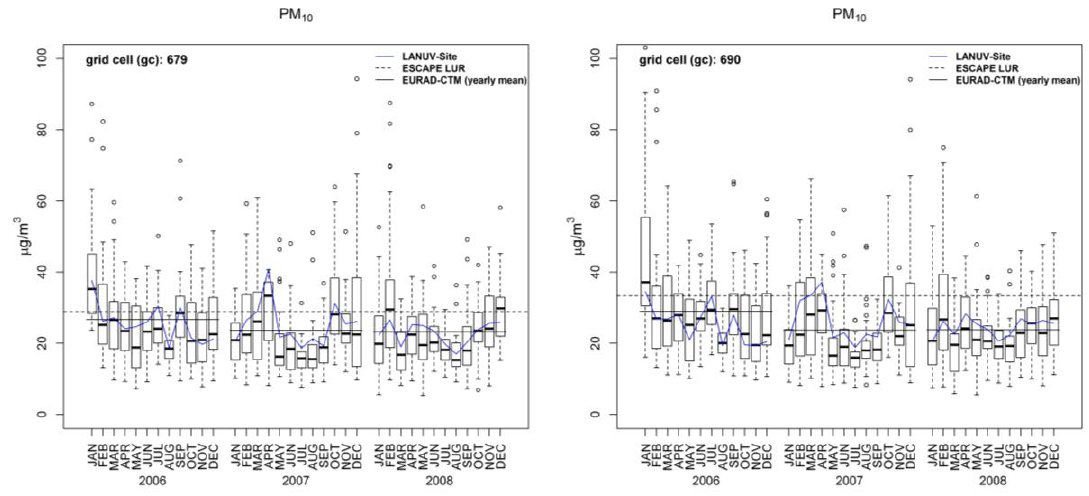
Figure 3. Box plots of air pollution concentrations of PM 10 over time for two grid cells (gc), representing background (gc: 679) and traffic (gc: 690), estimated by EURAD-CTM on a monthly and yearly basis, long-term ESCAPE-LUR estimation and measured at monitoring sites on a monthly basis (median per month).